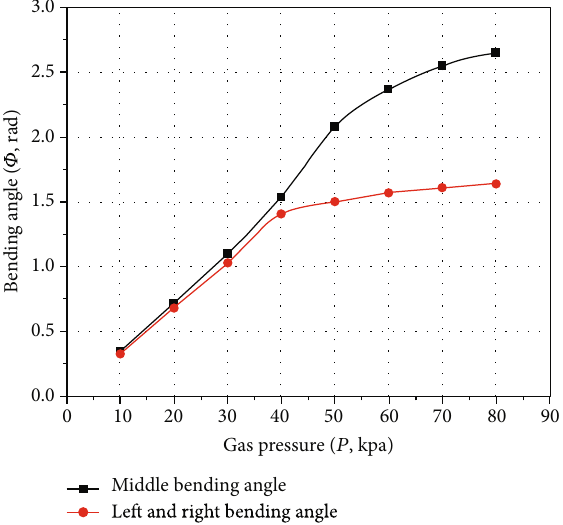
Figure 14: P − Φ characteristic curves of pneumatic soft-bodied bionic actuator.